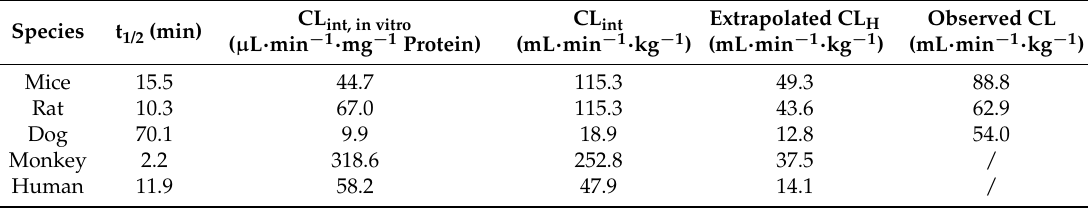
Table 2. Metabolic stability of C118 in liver microsomes of different